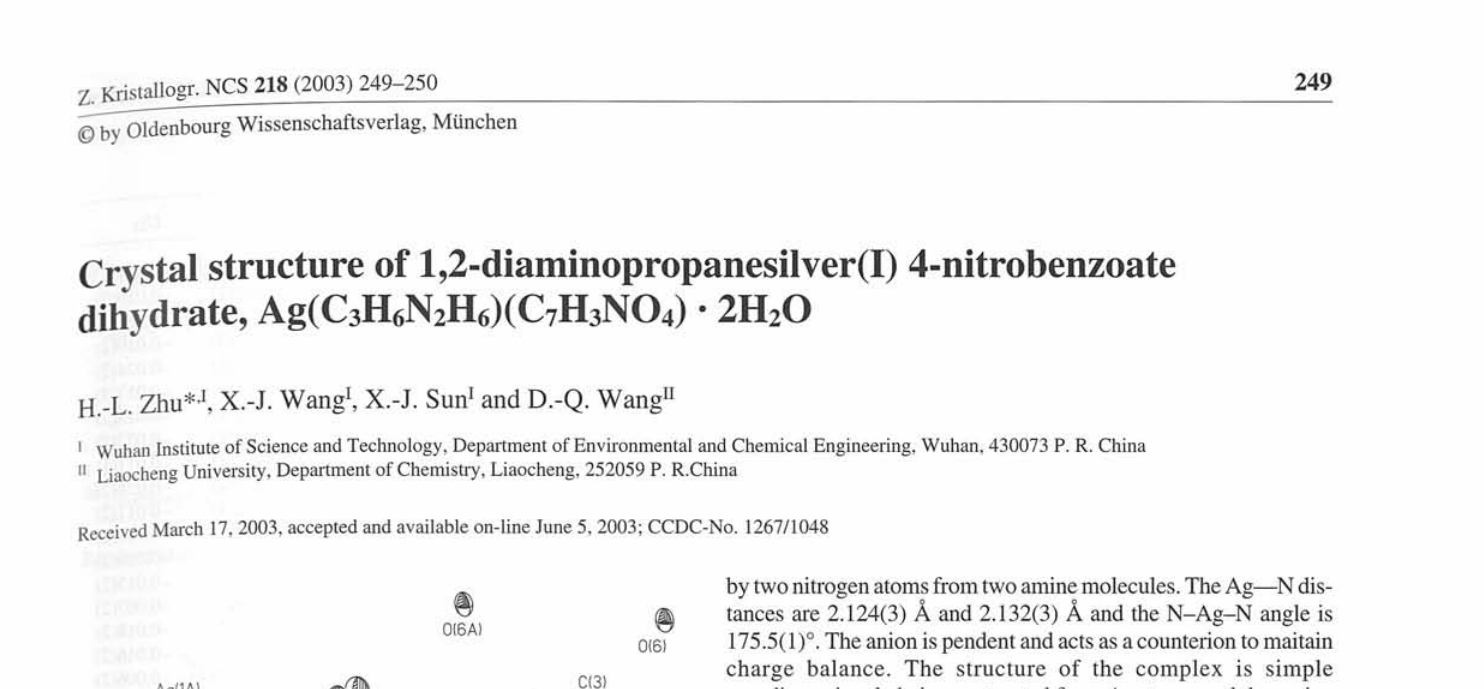
Table 1. Data collection and handling.